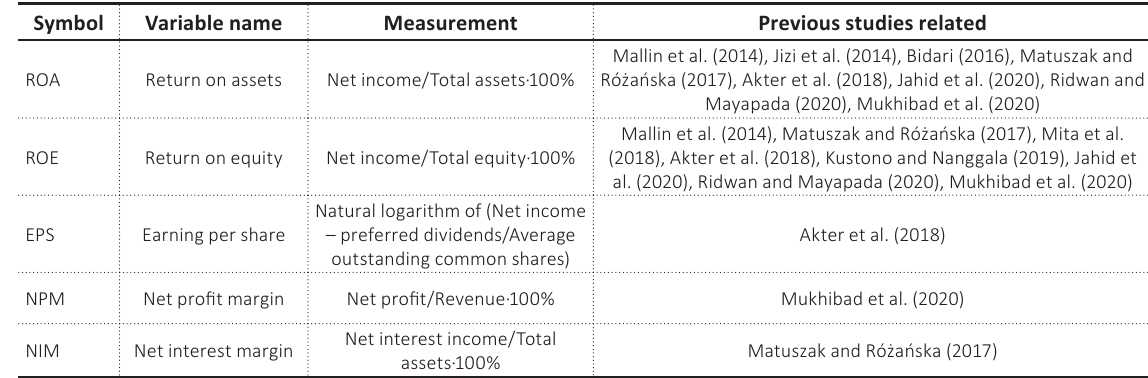
Source: Author’s